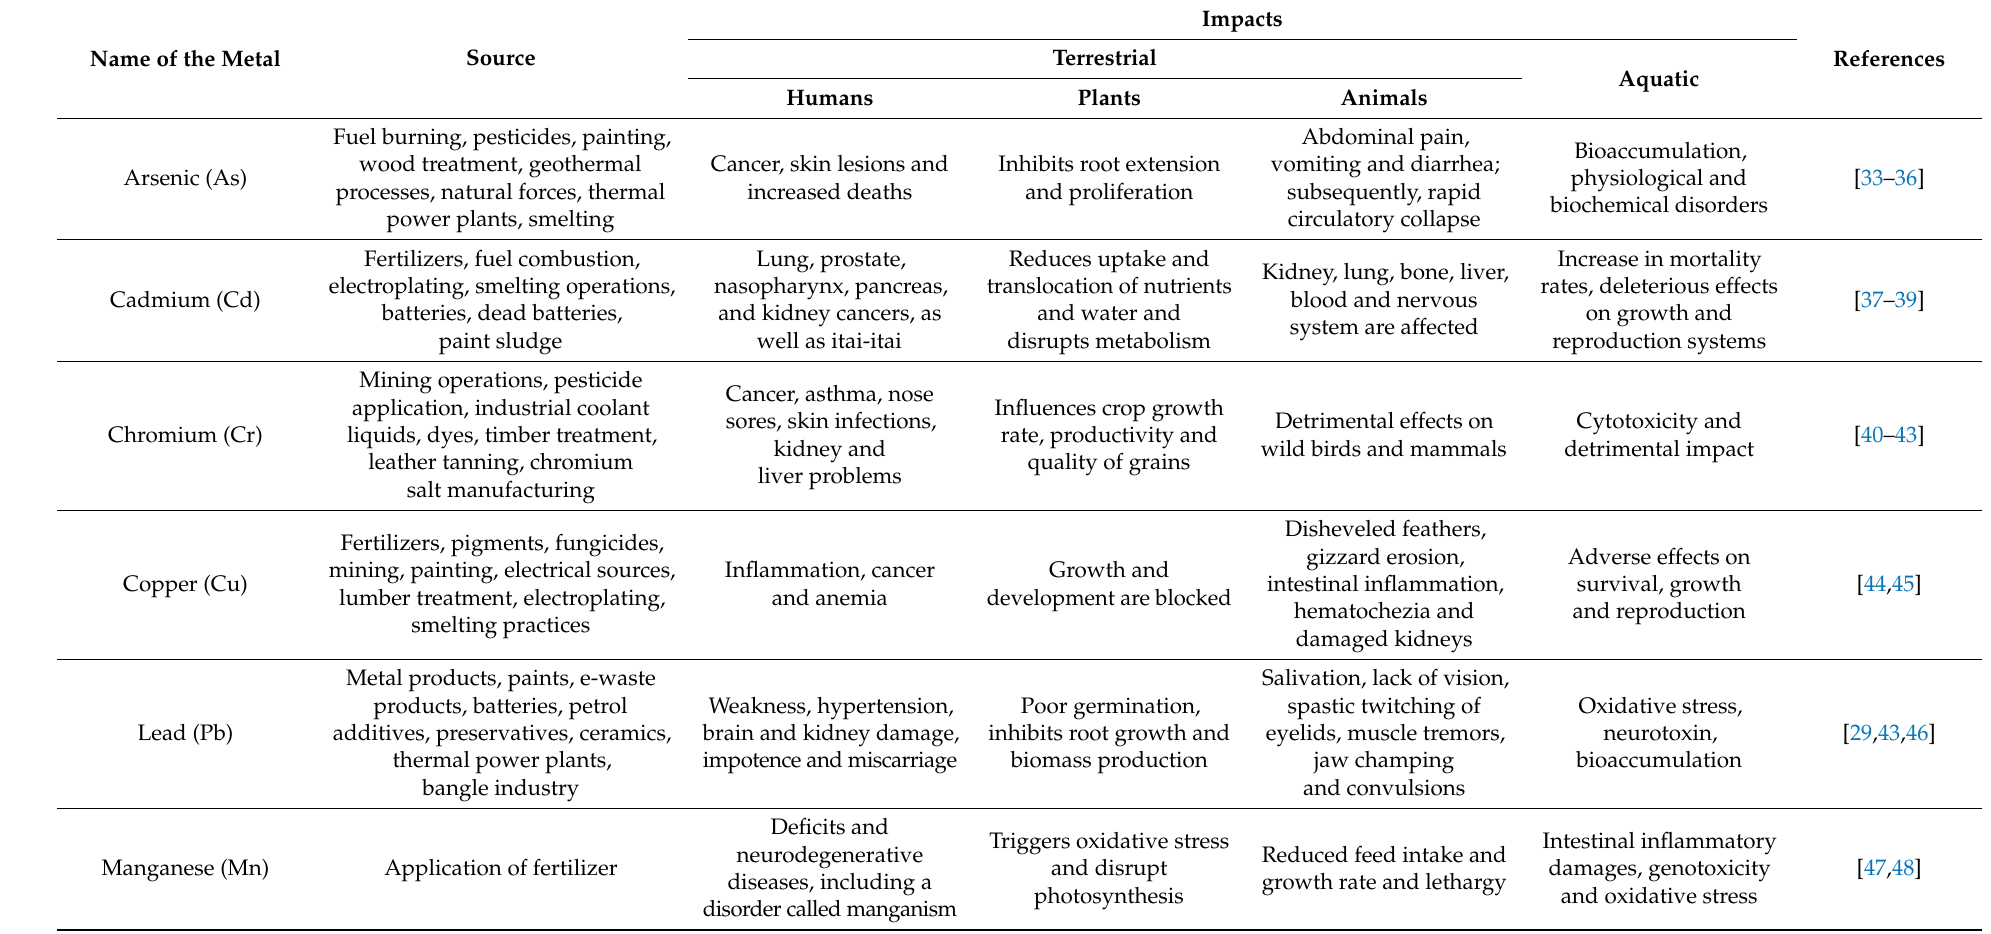
Table 2. Sources of heavy metal contamination and metals’ adverse impacts on terrestrial and aquatic life